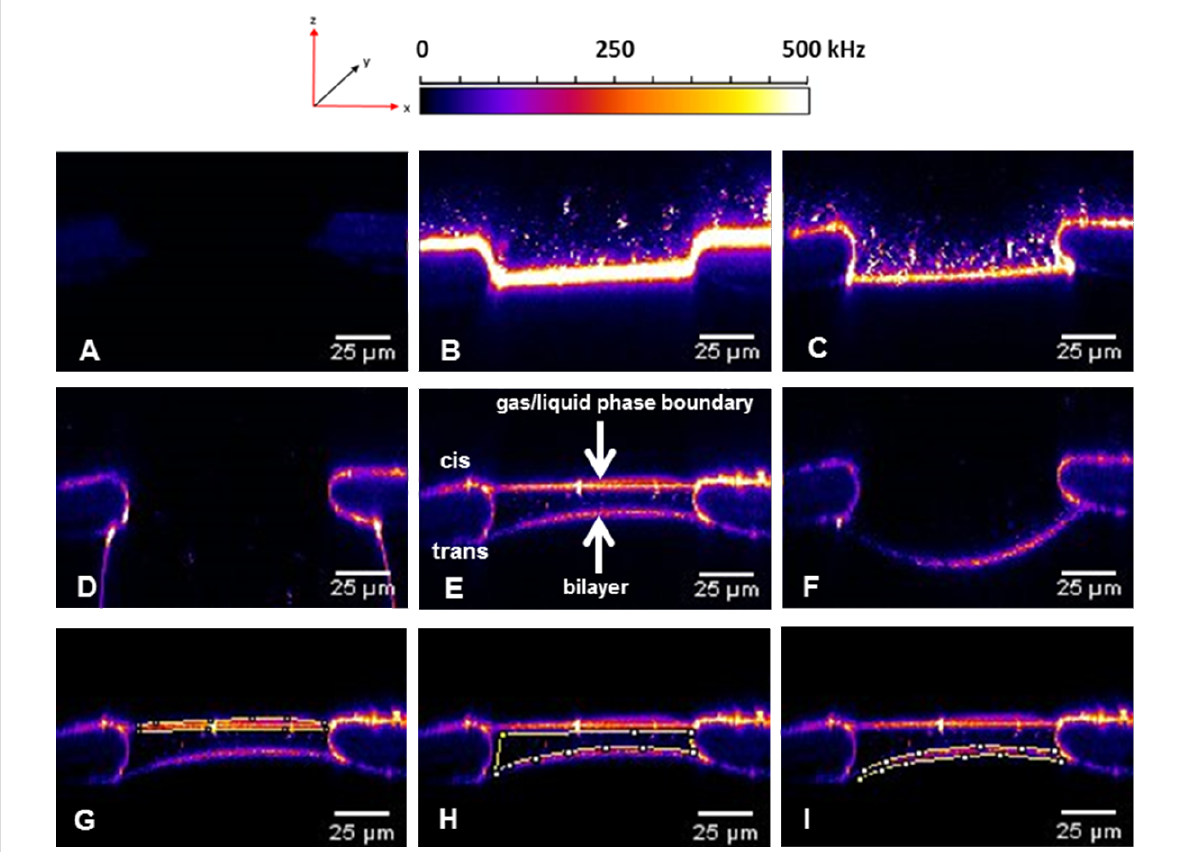
Figure 9: Infiltration of lipo-oligonucleotide ( 13 ) aggregates from the buffer into the lipid bilayer. Z-direction scan A) of a pure lipid bilayer without fluo- rescence, B) after the fourth perfusion/incubation step with high bilayer fluorescence and an accumulation of fluorescent aggregates/micelles above the bilayer. C) Z-direction scan of the bilayer after the ninth perfusion/incubation step, resulting in decreased bilayer brightness and an increased amount of micelles. D) After the 13th perfusion/incubation step, the bilayer sags into the trans compartment. After the 14th perfusion the bilayer returns to the starting position. E) After the 22nd perfusion/incubation step, the air–buffer boundary of the cis compartment was lowered over the bilayer. F) Z-direction scan after raising the buffer out of the focus. Brightness of the air–buffer boundary and of the lipid bilayer, each determined within the region of interest. G) The brightness of the liquid–air boundary is approximately 100,000 kHz. H) The brightness of the area between the two boundaries is approximately 28,000 kHz, and the brightness of the bilayer is approximately 50,000 kHz. I) The ratio of the brightness values of the liquid–air boundary and that of the bilayer is